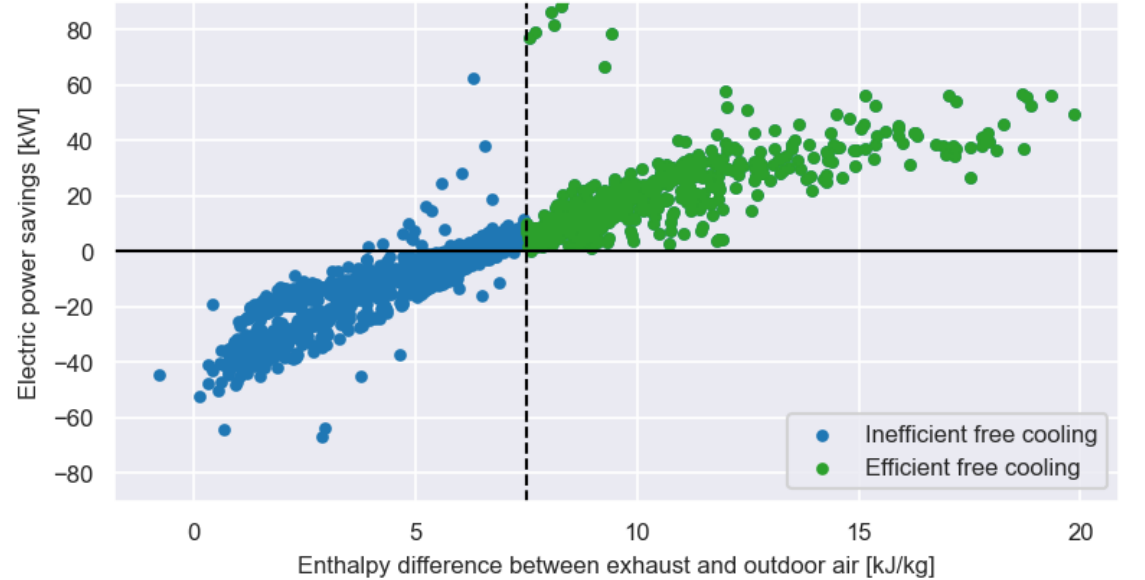
Figure 10. Reduction in total electric power of chilled water system and AHU fans by using free cooling as a function of the enthalpy difference between exhaust and outdoor air.